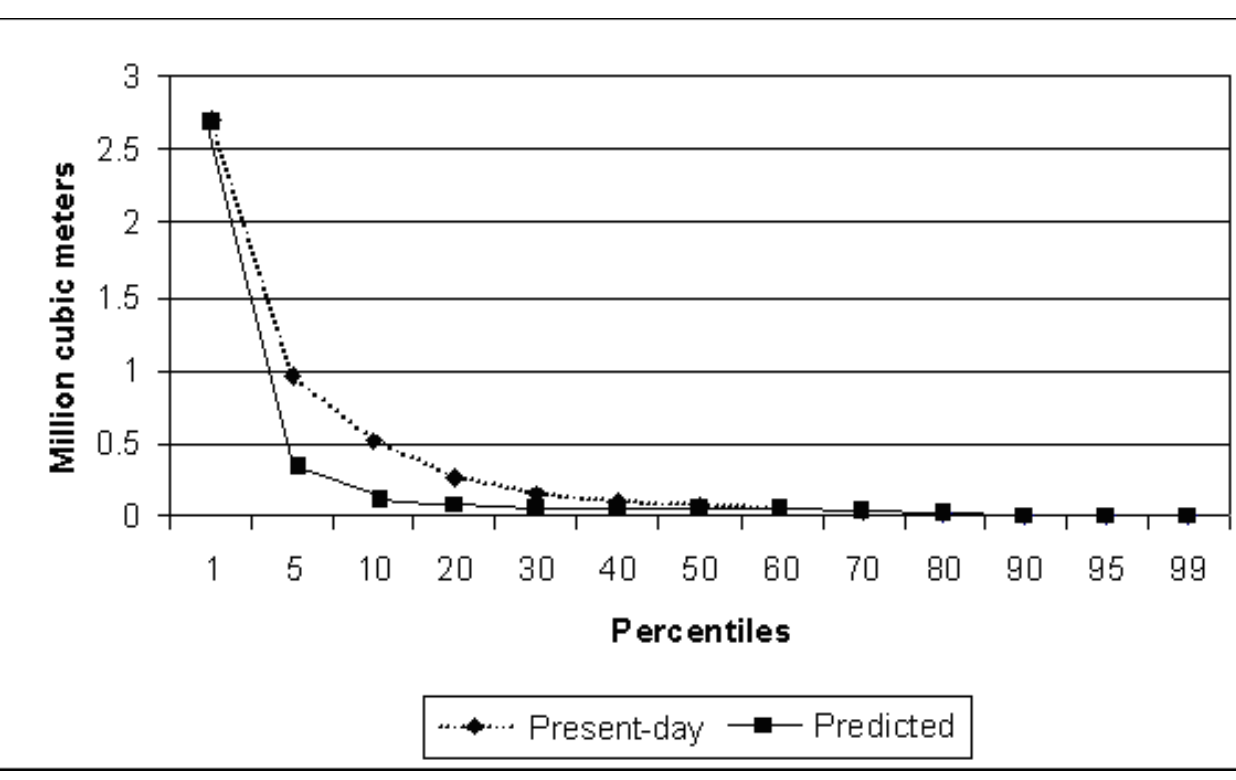
Fig. 1 . Present-day and predicted flow duration curves constructed from 20 yr of daily flow